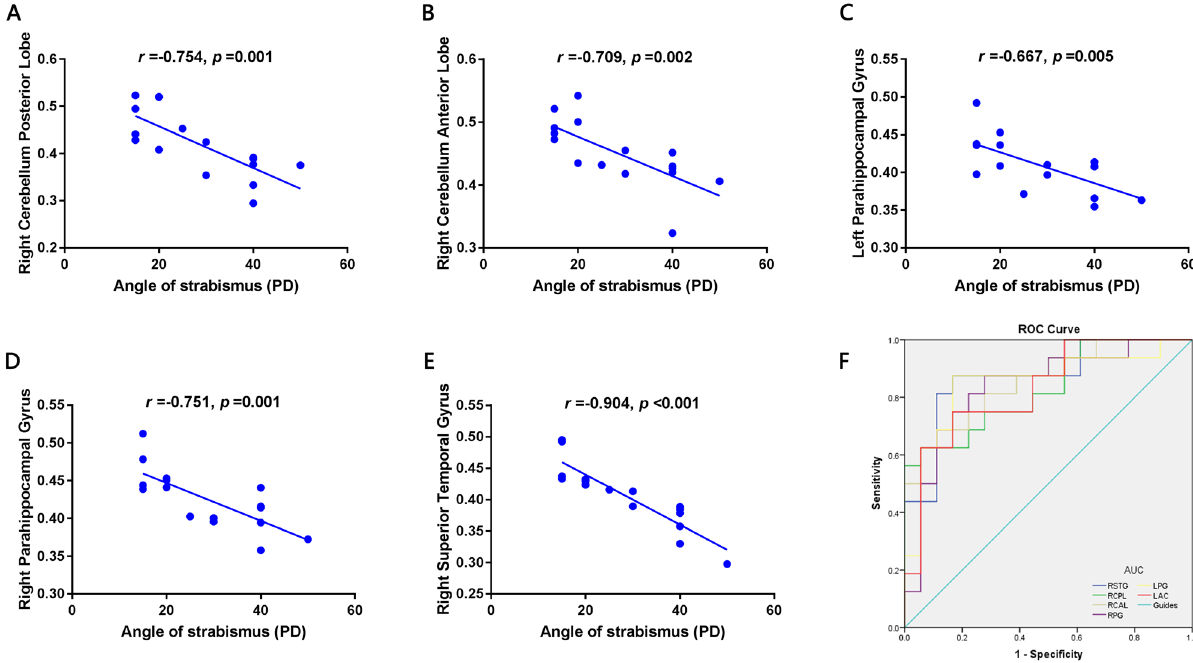
Figure 2. Correlations and ROC curve analysis of the mean GMV values in different regions and the clinical behaviors in SA group. Notes : ( A – E ) The angle of strabismus showed a negative correlation with the GMV values of the right posterior lobe of cerebrum ( r = − 0.754, p = 0.001), right anterior lobe of cerebrum ( r = − 0.709, p = 0.002), left parahippocampal gyrus ( r = − 0.667, p = 0.005), right parahippocampal gyrus ( r = − 0.751, p = 0.001), right superior temporal gyrus ( r = − 0.904, p < 0.001). ( F ) The area under the ROC curve were 0.872, ( P < 0.001; 95% CI 0.748–0.995) for RSTG, RCPL 0.830 ( p = 0.001; 95% CI 0.692–0.968), RCAL 0.854 ( p < 0.001; 95% CI 0.729–0.980), RPG 0.837 ( p = 0.001; 95% CI 0.696–0.978), LPG 0.851 ( p < 0.001; 95% CI 0.710–0.991), LAC 0.830 ( p = 0.001; 95% CI 0.691–0.969). GMV gray matter volume, SA strabismus with amblyopia, PD , prism diopter, ROC receiver operating characteristic, RSTG right superior temporal gyrus, RCPL posterior lobe of right cerebellum, RCAL right anterior lobe of cerebellum, RPG right parahippocampal gyrus, LPG left parahippocampal gyrus, LAC left anterior